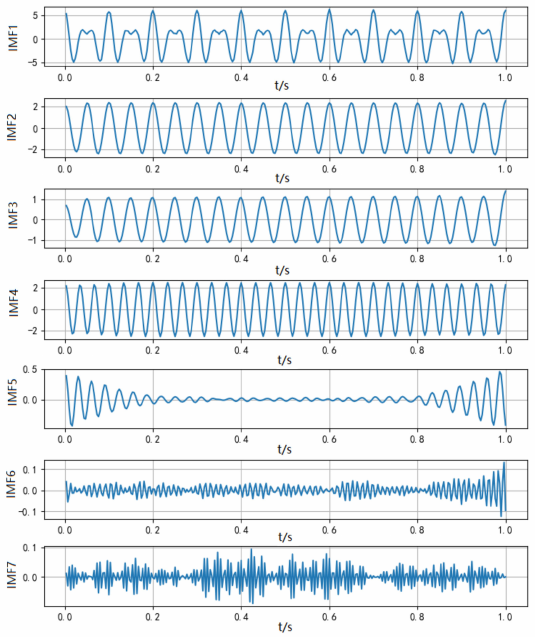
Figure 8. VMD Decomposition Sequence Diagram of Fault 5 Signal.